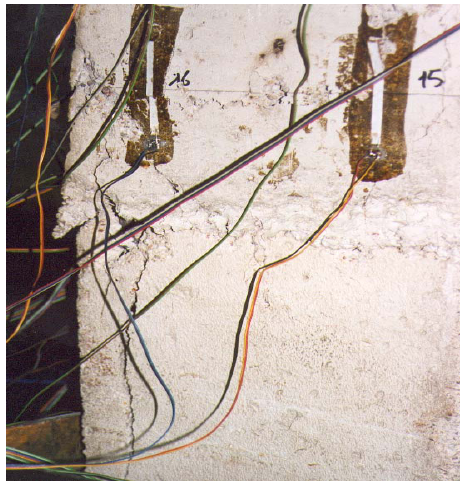
Fig 11 . Reloaded column at the moment of failure. In the picture a visible fragment of column under head from fi- bre concrete is